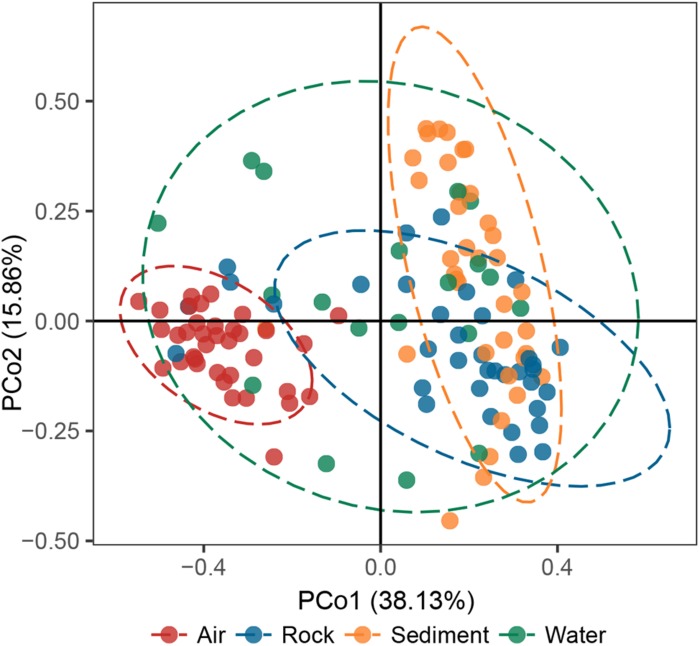
Principal coordinates analysis (PCoA) ordination of variation based on weighted UniFrac dissimilarity. The dotted lines indicate the 95% confidence intervals grouped by cave niche.